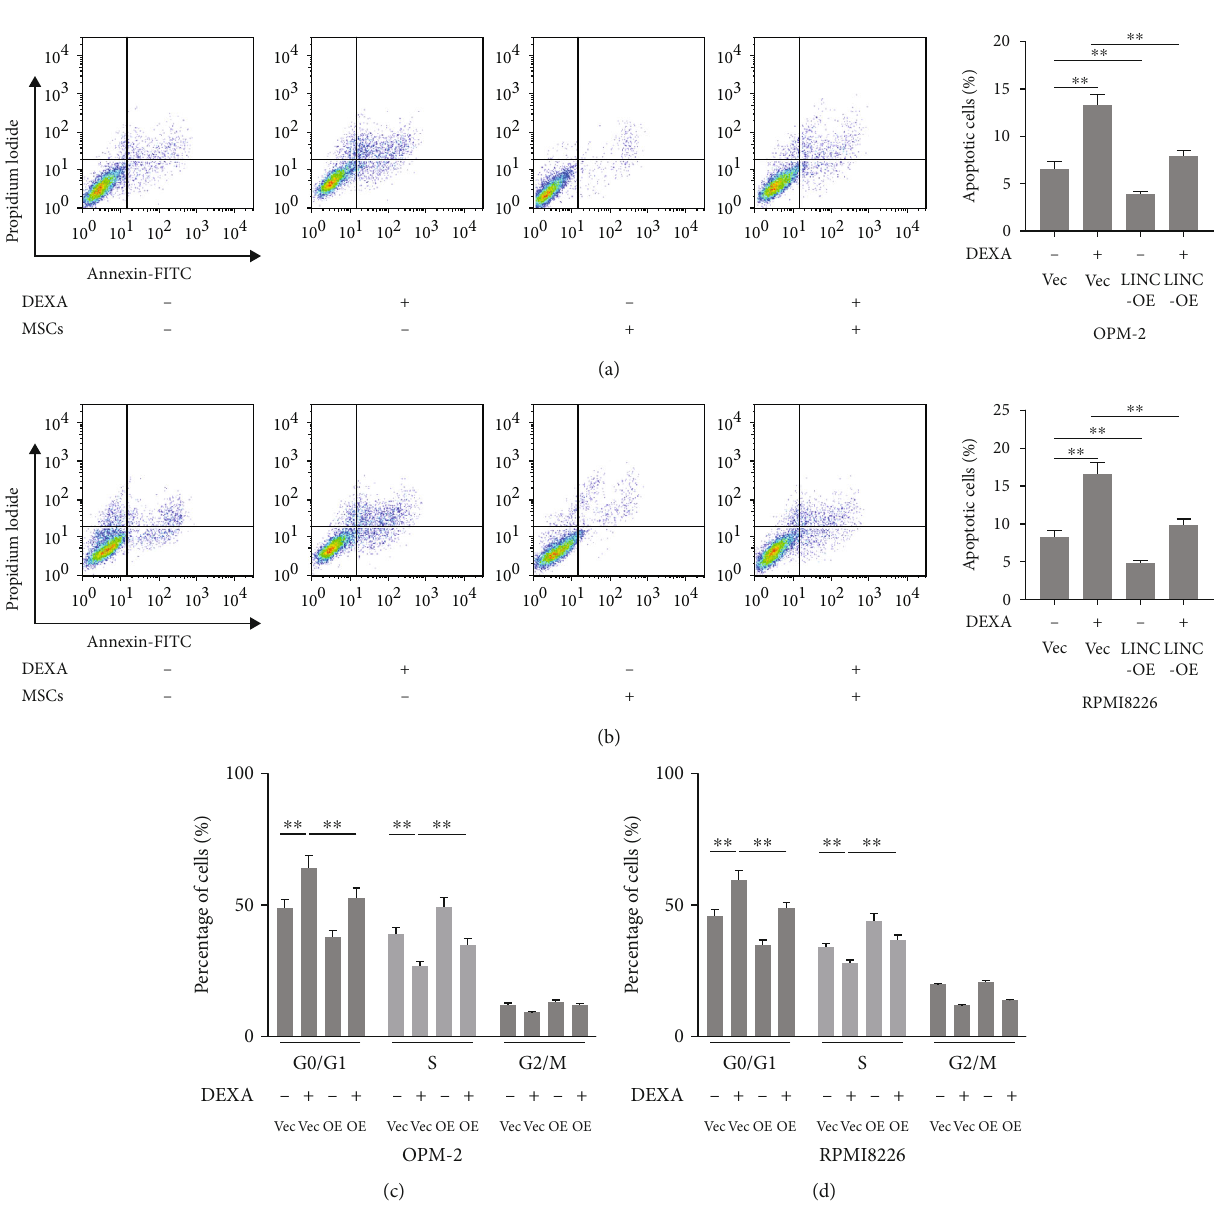
Figure 5: The overexpression of LINC00461 regulated the e ff ects of dexamethasone on cell apoptosis and cell cycle distribution. (a, b) Cells were treated with or without dexamethasone (10 μ M). After 48 hours, cell apoptosis assay was determined by using fl ow cytometry. Besides, (c, d) cell cycle distribution was also determined by fl ow cytometry. One-way ANOVA. ∗∗ p < 0 : 01